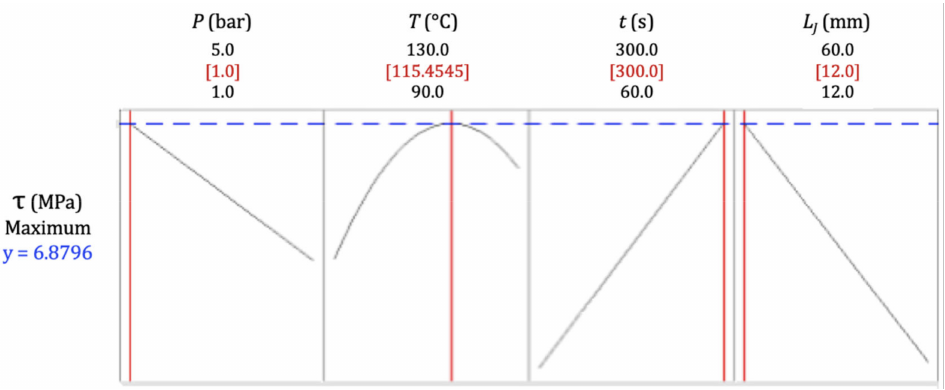
Figure 12. Optimized maximum shear stress and respective processing parameters obtained via multiple response